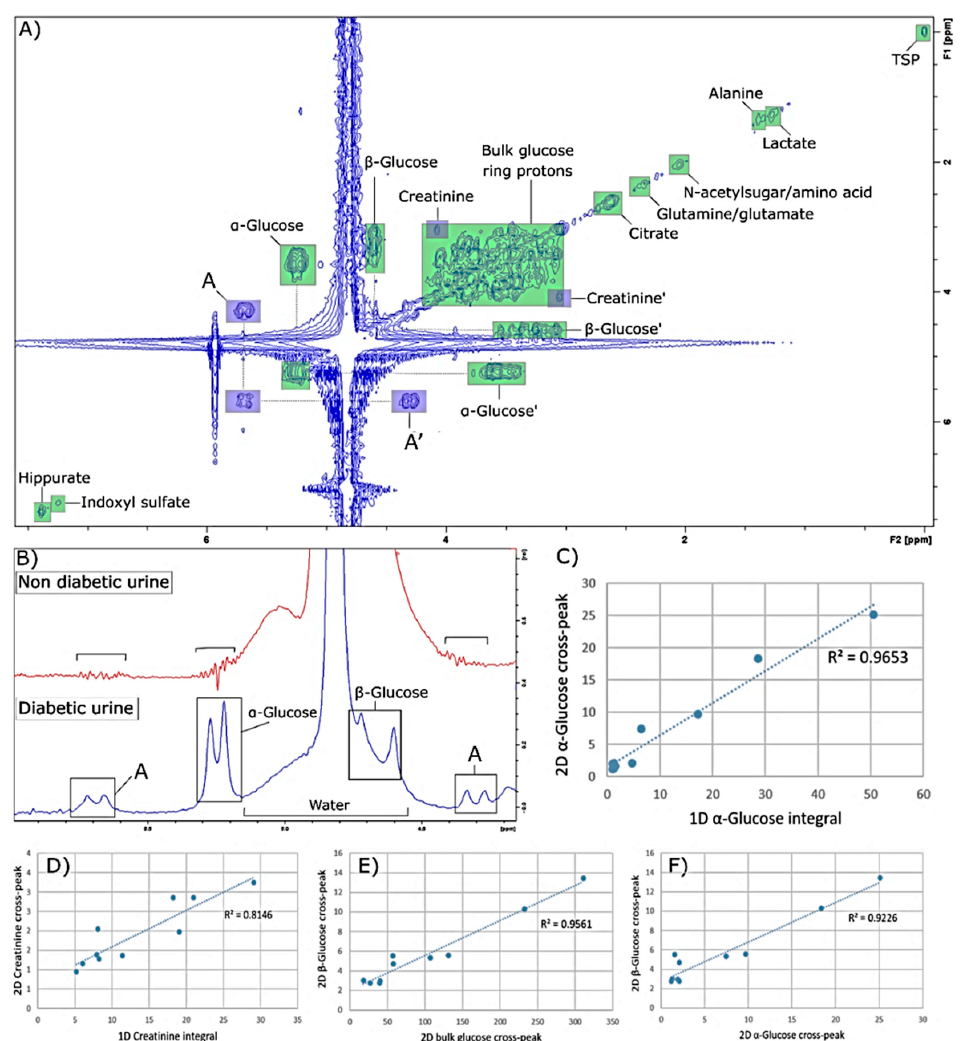
Figure 1. Investigation of 2D 1 H- 1 H COSY low-frequency NMR spectra. ( A ): 2D 1 H- 1 H COSY NMR T2D urinary profile acquired at 60 MHz using a benchtop NMR facility. Creatinine blue squares represent the long-range connectivity cross-peak for this metabolite. Blue squares labelled A represent unassigned, unusual doublet resonances arising from ‘mirroring’ spectral signal located at δ = 5.13–5.29 ppm (in this case, reflecting the α -glucose cross-peak). ( B ): Unassigned 4.38 and 5.70 ppm doublet resonances, detectable in the 1D 60 MHz NMR profile of a urine sample collected from a hyperglycaemic T2D patient, but completely absent from that of a healthy control participant. Urea, which is observable in HF 400 MHz spectra and resonates at ~5.80 ppm, was not readily observable in our LF spectra in view of its broadness and overlap with the unassigned δ = 5.70 ppm signal. Typical spectra are shown. ( C , D ): Linear correlations between 1D and 2D integrals of α -glucose’s C1-H 5.25 ppm resonance ( C ), and that of creatinine’s N-CH 3 function at δ = 3.06 ppm ( D ). ( E , F ): Linear correlations between 2D cross-peaks signal integrals of β -glucose’s C1-H signal versus those of glucose bulk ring ( E ), and α -glucose’s C1-H function ( F